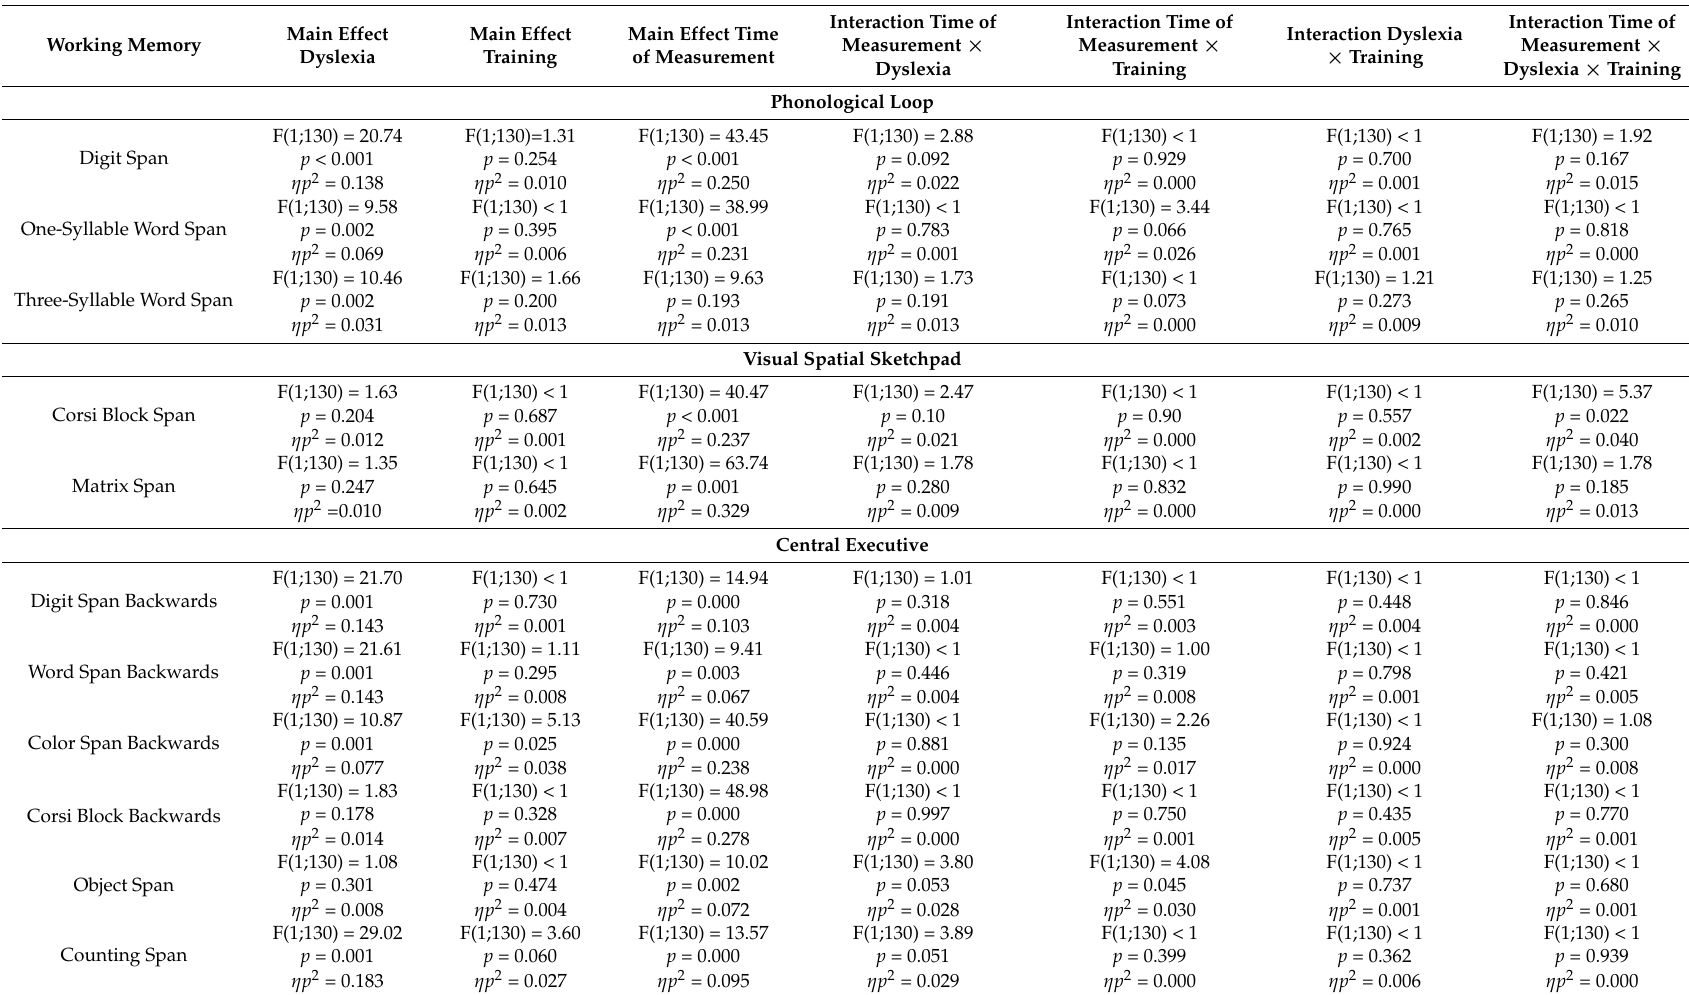
Table 4. Results